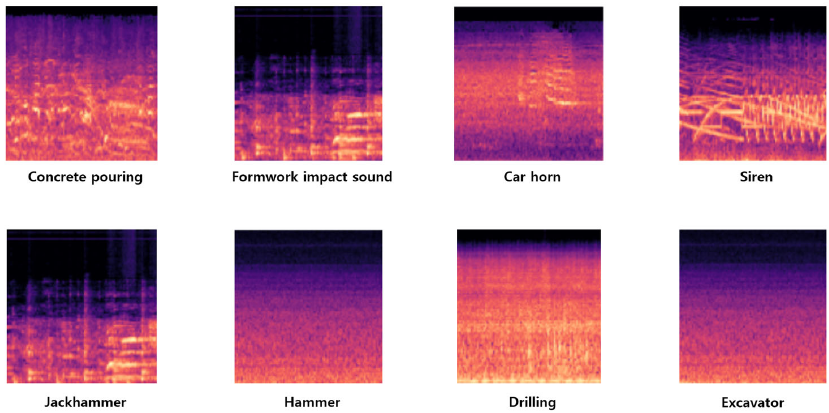
Figure 9. Image of sound data pre-processed for CNN model training.